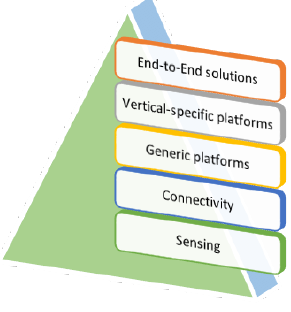
Figure 5 : IoT strategies for